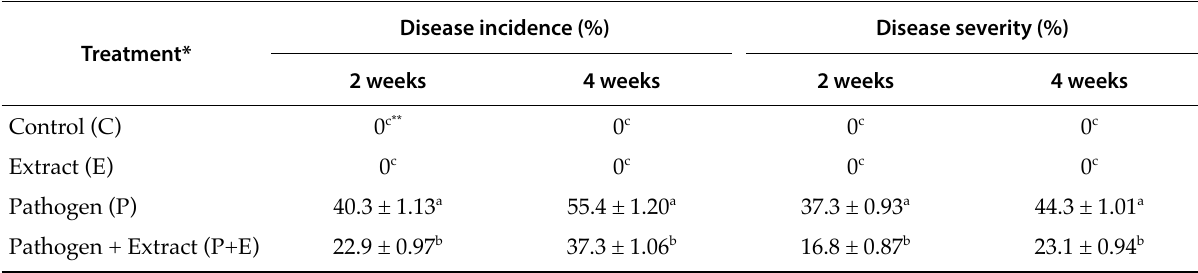
Table 3. Mean Fusarium root rot incidence and severity in 2 or 4 weeks after different treatments were applied to sunflower seeds.